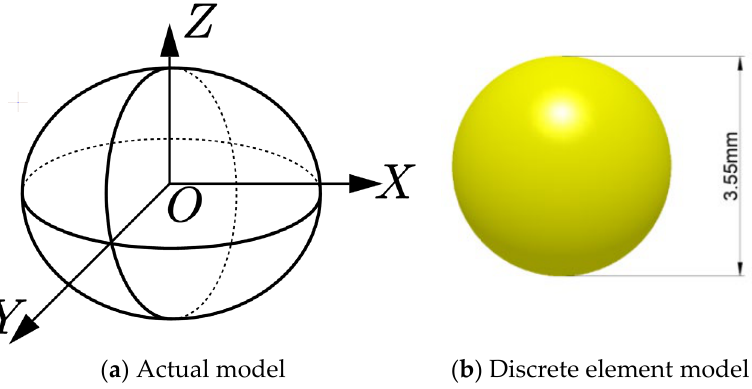
Figure 7. Actual model and discrete element model of compound fertilizer particles ( a , b ).